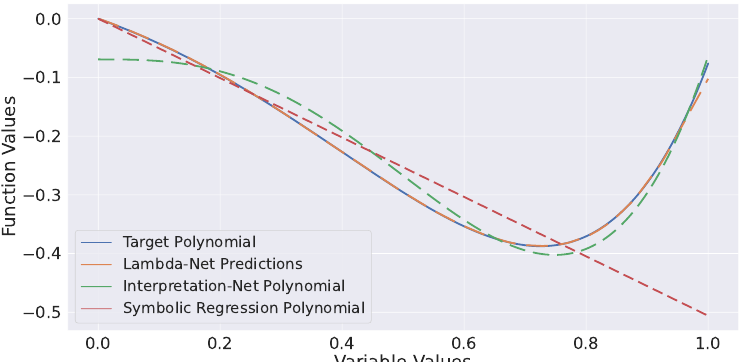
Figure 4. Exemplary visualization of the explanations. This plot visualizes the function generated by the evaluated approaches for n = 1 on an arbitrarily selected dataset. The corresponding mathematical expressions and their fidelity can be found in Table